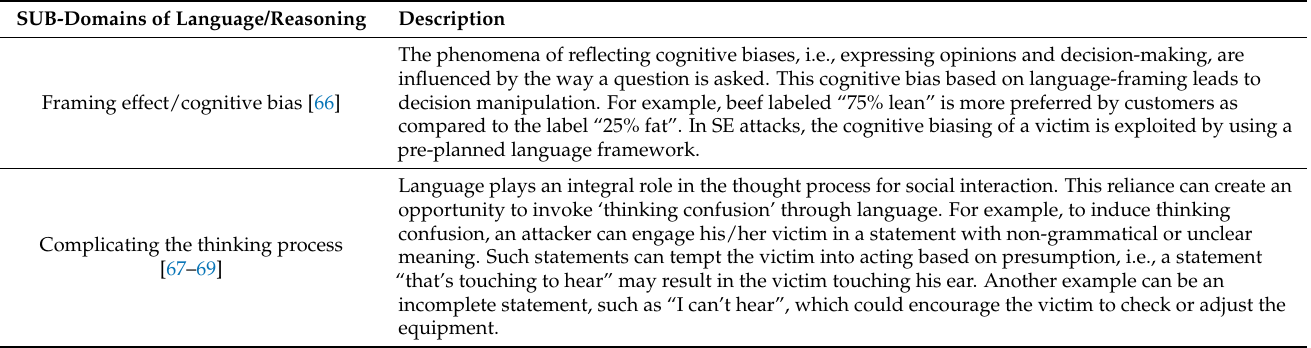
Table 7. Sub-domains of language/reasoning linked with social engineering attacks.